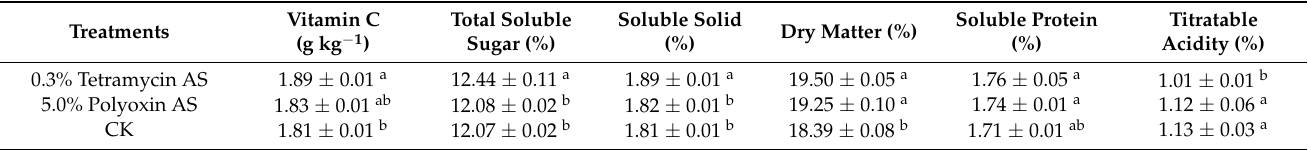
Table 5. The effects of tetramycin and polyoxin on the nutritional quality of kiwifruit. Treatments